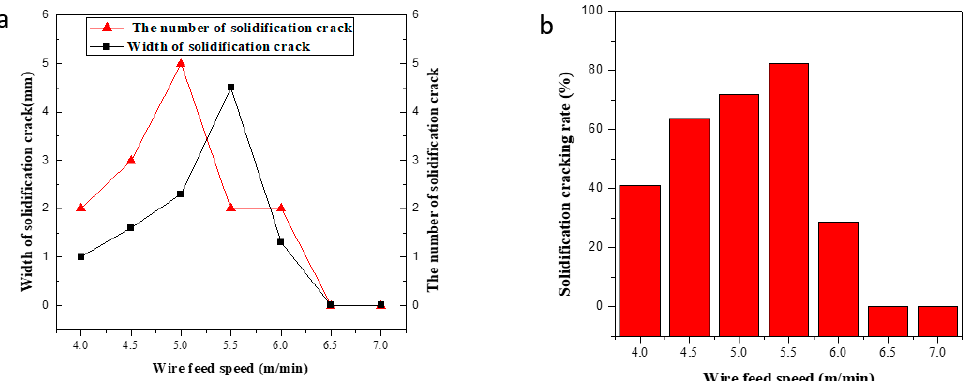
Figure 5. ( a ) Effect of wire feeding speed on the width and number of cracks; ( b ) effect of wire feeding speed on the crack rate.